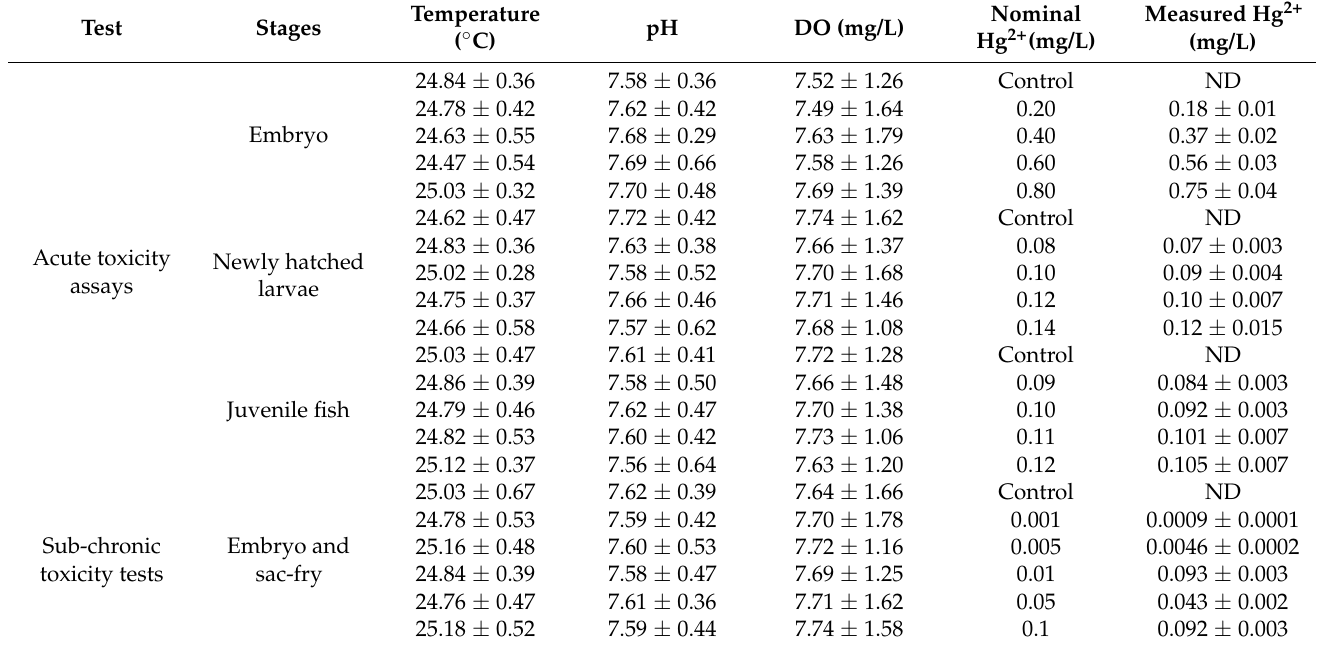
Table 1. Physicochemical parameters of water quality during the test.